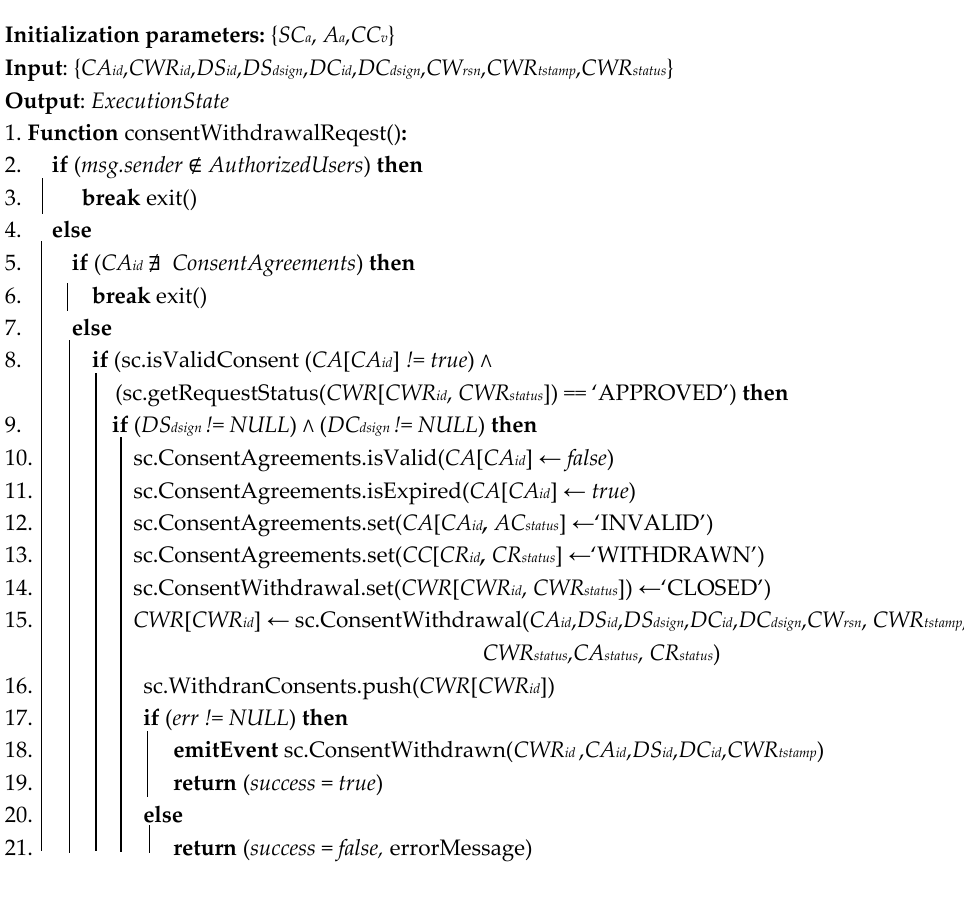
Figure 5. Consent withdrawal sequence diagram of the SC-DCMS. Algorithm 3 Consent withdrawal Algorithm 3: Consent